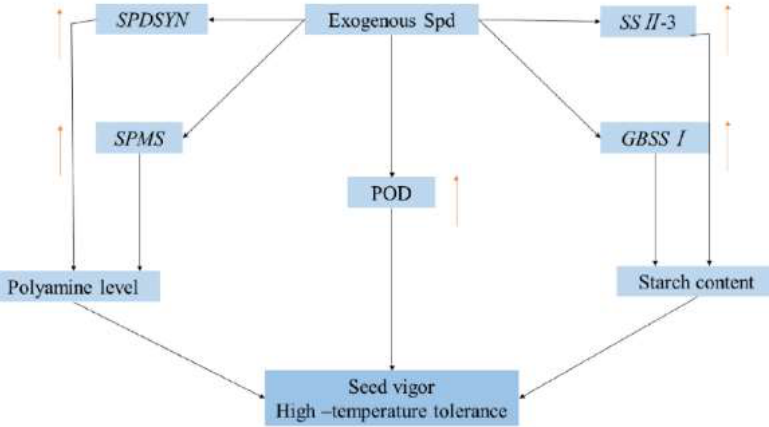
Figure 8. Schematic presentation of main metabolic pathways regulated by Spd in rice filling exposed to high-temperature stress.